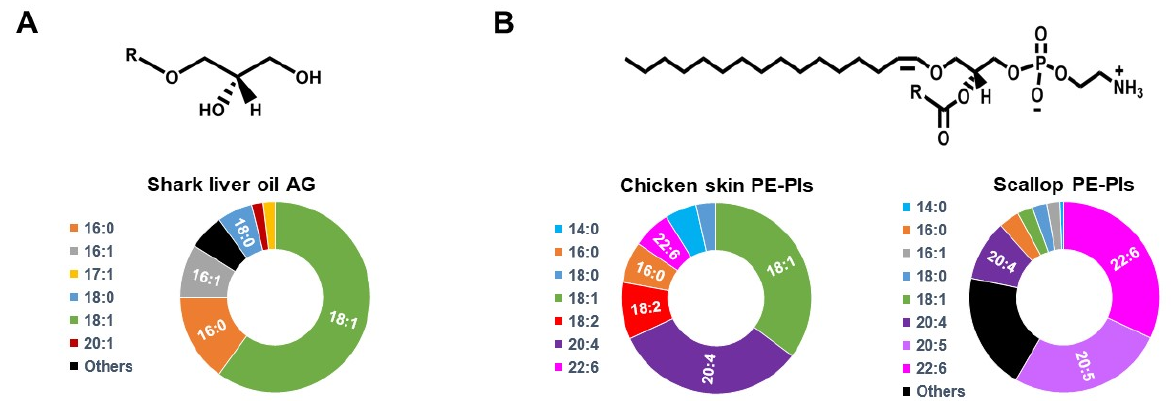
Figure 3. Plasmalogen and plasmalogen precursors in natural sources. ( A ) Alkylglycerols (AG) are enriched in shark liver oil. On top is a generic chemical structure of an AG. In the bottom the alkyl chain distribution of shark liver oil-purified AG (from [92]). ( B ) PE-Pls is the major plasmalogen found in chicken skin and scallops. On top is a generic chemical structure of PE-Pls. On the bottom is the acyl chain distribution of chicken-skin- and scallop-purified PE-Pls (from [71] and [93]).